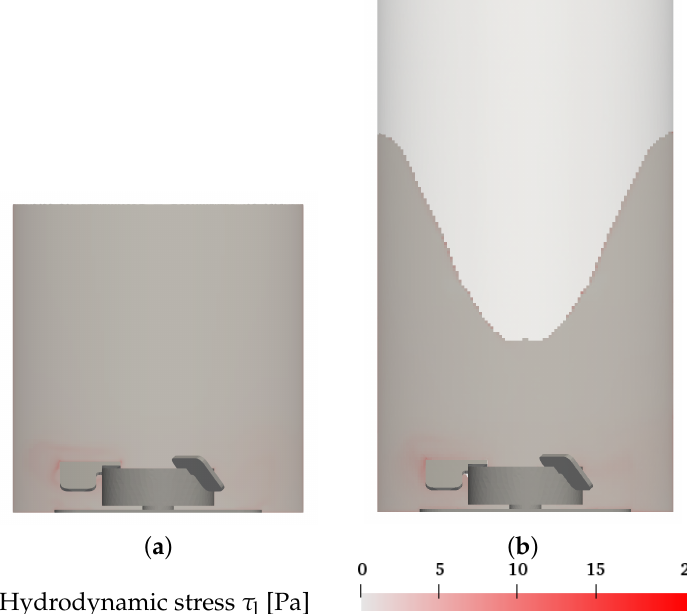
Figure 7. Hydrodynamic stress for the maximum impeller speed condition (7 L, 360 rpm, 0.25 Lmin − 1 , 2 µ m) in the x - z plane through the center of the vessel. ( a ) Euler–Lagrange results; ( b ) Euler–Euler results.